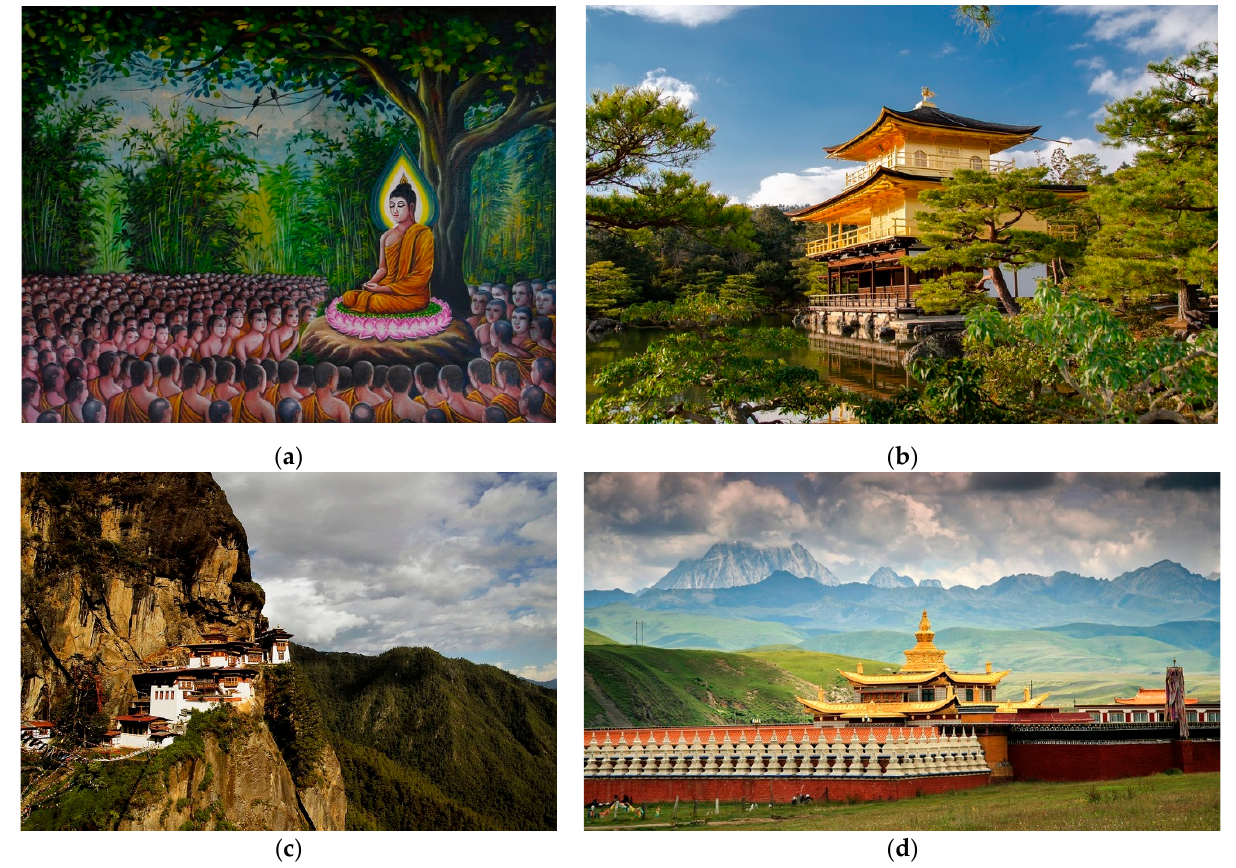
Figure 2. ( a ) Painting of Buddha teaching under the tree (source: Pixabay); ( b ) Kinkakuji Temple, Japan (source: Pixabay); ( c ) Paro Taktsang Monastery, Bhutan (source: Pixabay); ( d ) Tibetan monastery (source: Pixabay).